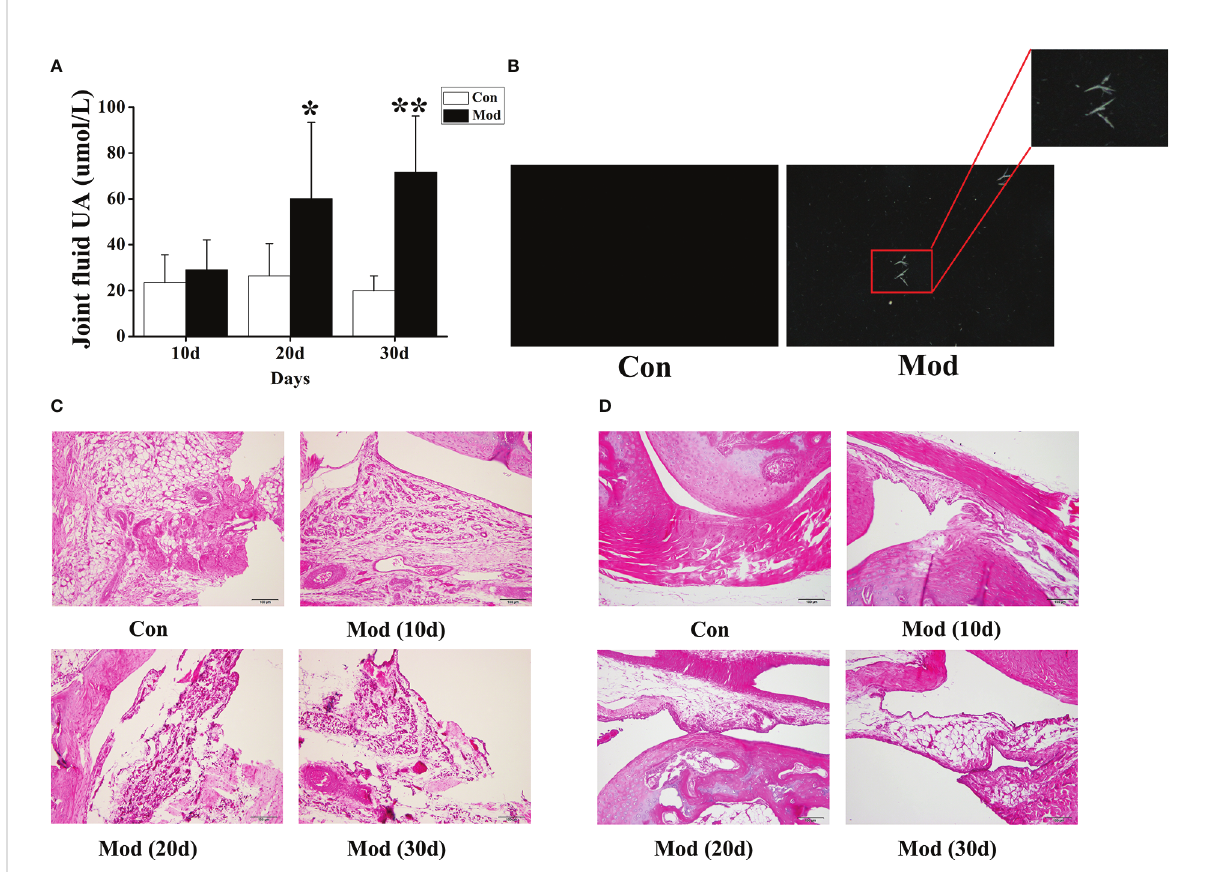
FIGURE 5 The levels of uric acid in joint fl uid and HE staining of joints of quails in different experimental stages. (A) The joint fl uid uric acid level of the quails. (B) The urate crystals appeared in the synovial fl uid of quails. (C) HE staining of ankle joint (200×). (D) HE staining of claw joint (200×). Data are expressed as mean ± SEM for 8 quails in each group. * P < 0.05 and ** P < 0.01 versus Con